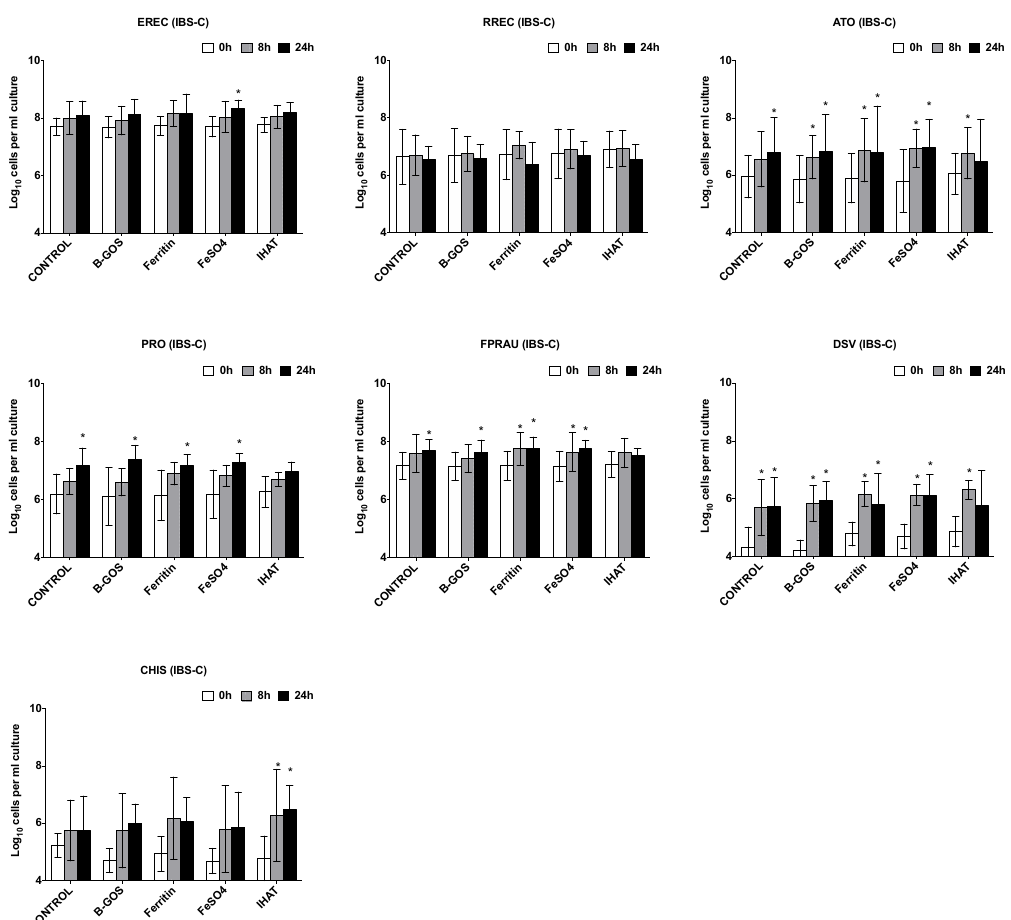
Figure 4. Effect of different substrates on bacterial groups detected by flow-FISH in pH-controlled batch cultures inoculated with faeces from diarrhoea-predominant IBS (IBS-C) donors. Samples were collected at 0 h (baseline), 8 h and 24 h. Target bacteria: Bifidobacterium spp. (BIF), Lactobacillus spp. (LAB), most Bacteroidaceae and Prevotellaceae (BAC), Clostridium coccoides – Eubacterium rectale group (EREC), Roseburia subcluster (RREC), Faecalibacterium prausnitzii (FPRAU), Clostridium cluster IX (PRO), Atopobium – Coriobacterium spp. (ATO), Desulfovibrio (DSV) and Clostridium histolyticum (CHIS). Values are the mean from five independent experiments ± SD. Differences between substrates are not statistically significant. *, significant differences from the baseline condition (i.e., time-point 0 h) for each substrate, p < 0.05.